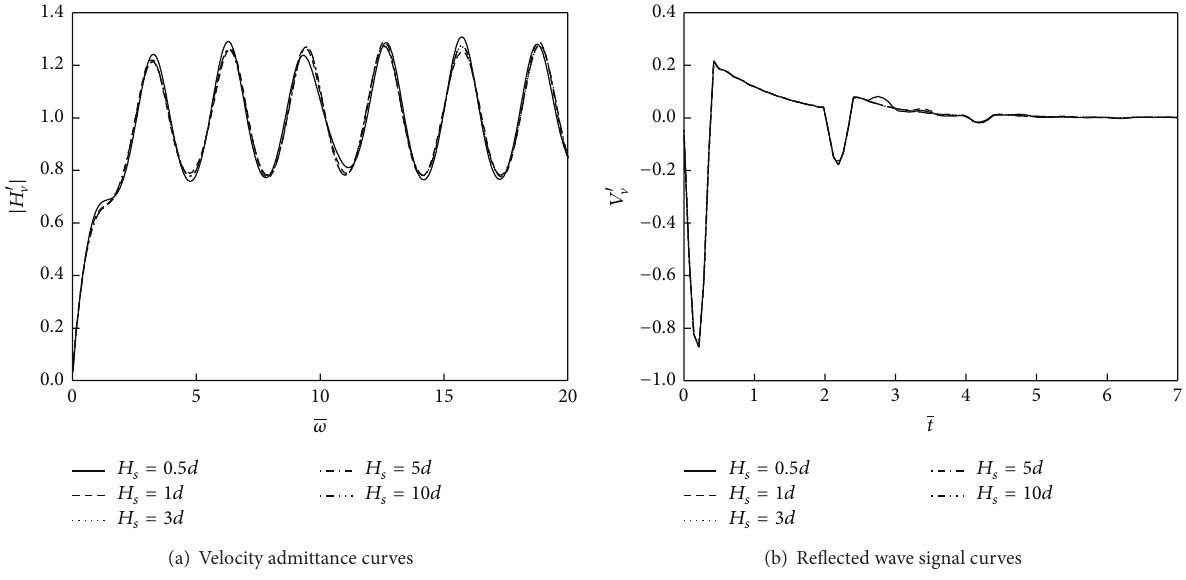
Figure 7: Influence of thickness of pile end soil on the dynamic response at pile head when 𝑉 𝑝,2 = 4000 m /